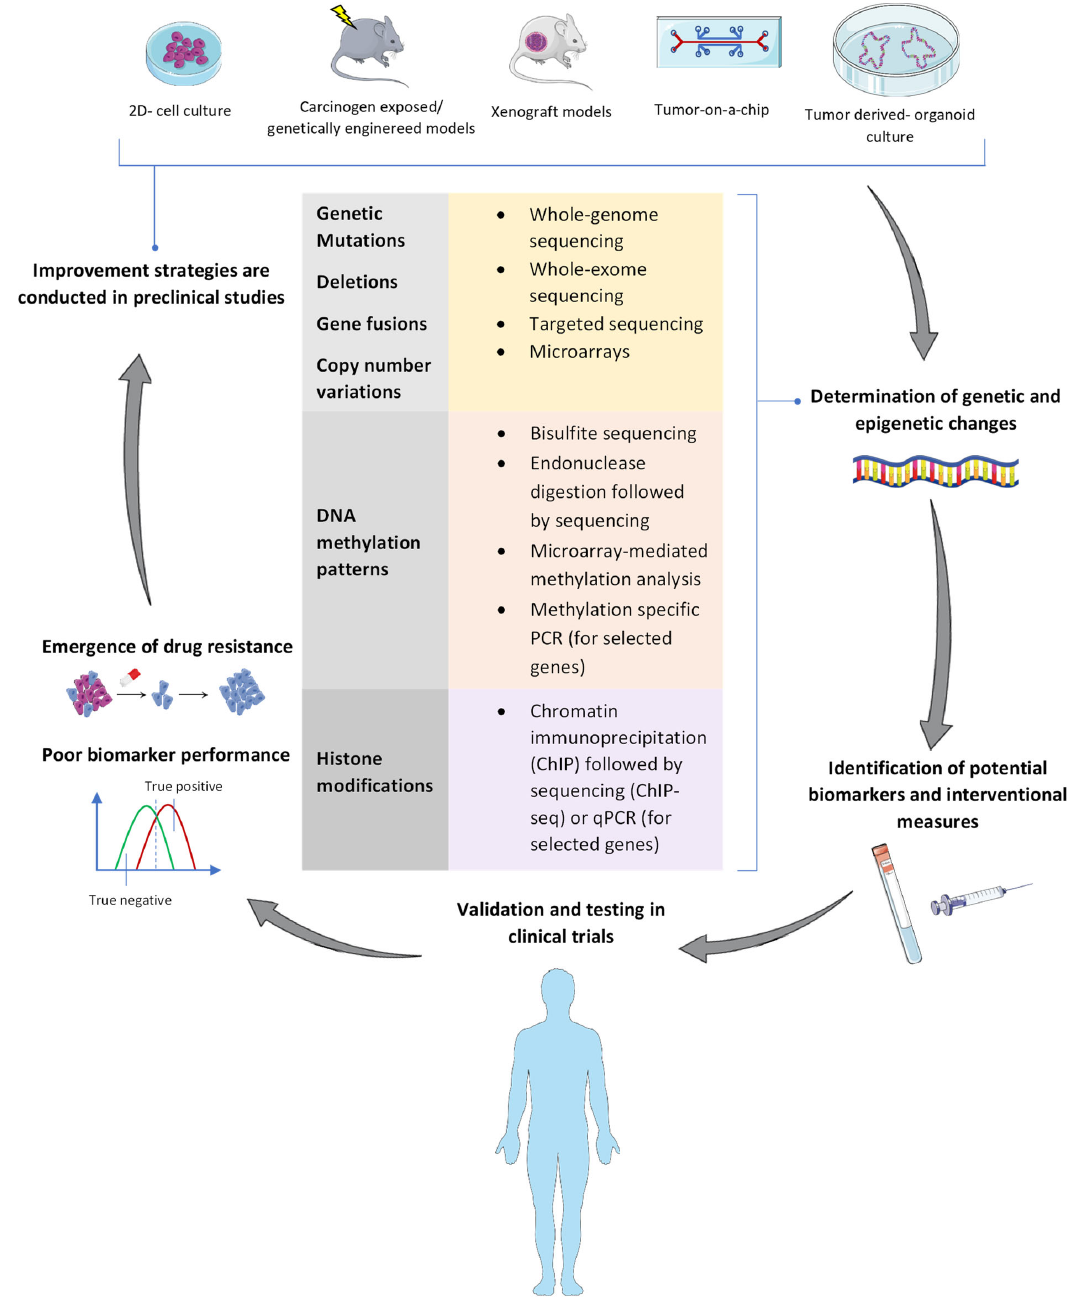
Figure 1. Development of new biomarkers and therapeutic approaches for cancer treatment: A bi-directional process. Bench to bedside; Experimental models used in cancer research can vary from 2D-cell culture to murine in vivo models to more complex 3D patient-derived cancer organoids. These models can identify cancer-related genetic and epigenetic signatures using a plethora of sequencing and targeted qPCR techniques, which can then be utilized to predict novel cancer biomarkers and therapeutic targets to be eventually translated into clinical practice. Bedside to bench; the poor performance of some biomarkers or the emergence of drug resistance to anticancer agents may contribute to their failure to reach the clinic. This urges preclinical studies to test new biomarker panels or to find new strategies to overcome drug resistance with the aim to improve therapeutic outcomes of cancer patients.